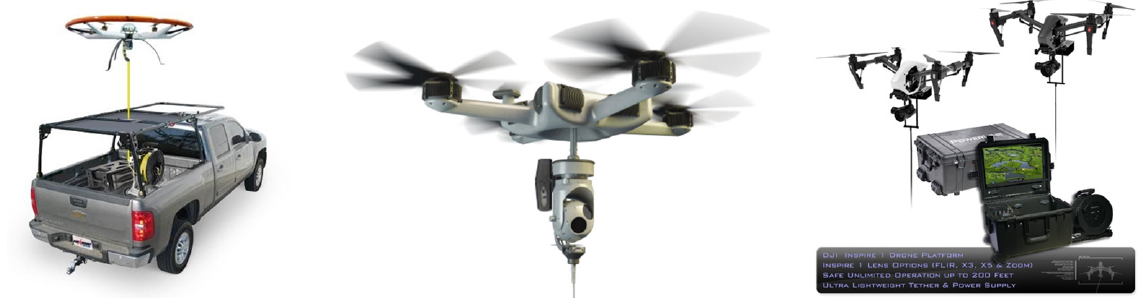
Figure 2. Tethered multicopters and tethered flight system for multicopters: T-Rotor [13], Hover Mast [14], Power Line [15].